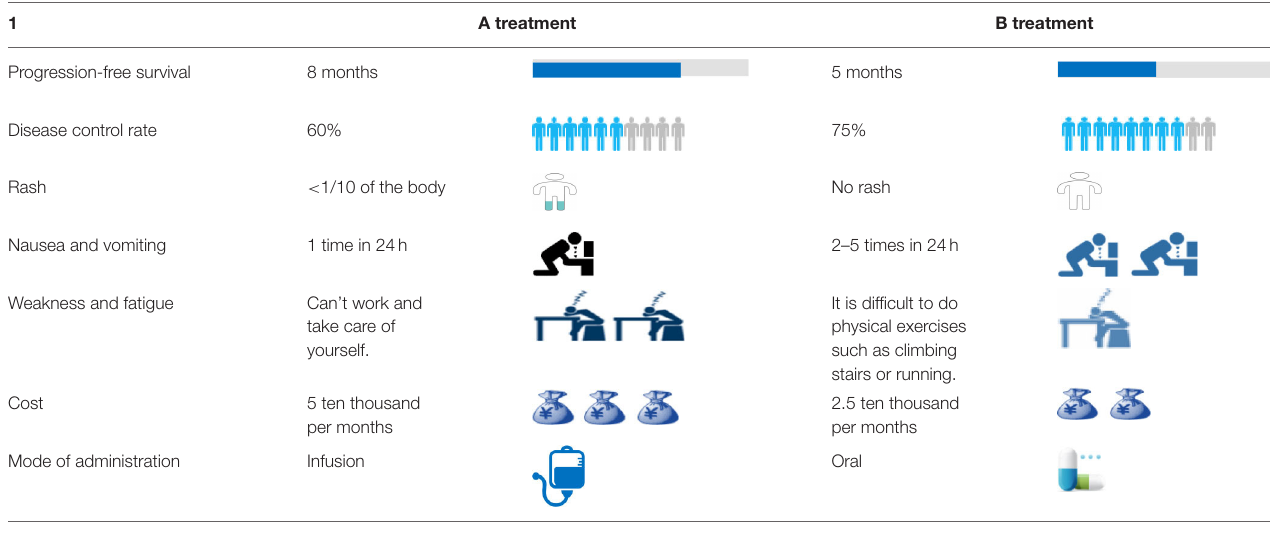
TABLE 3 | Example choice set of the discrete-choice